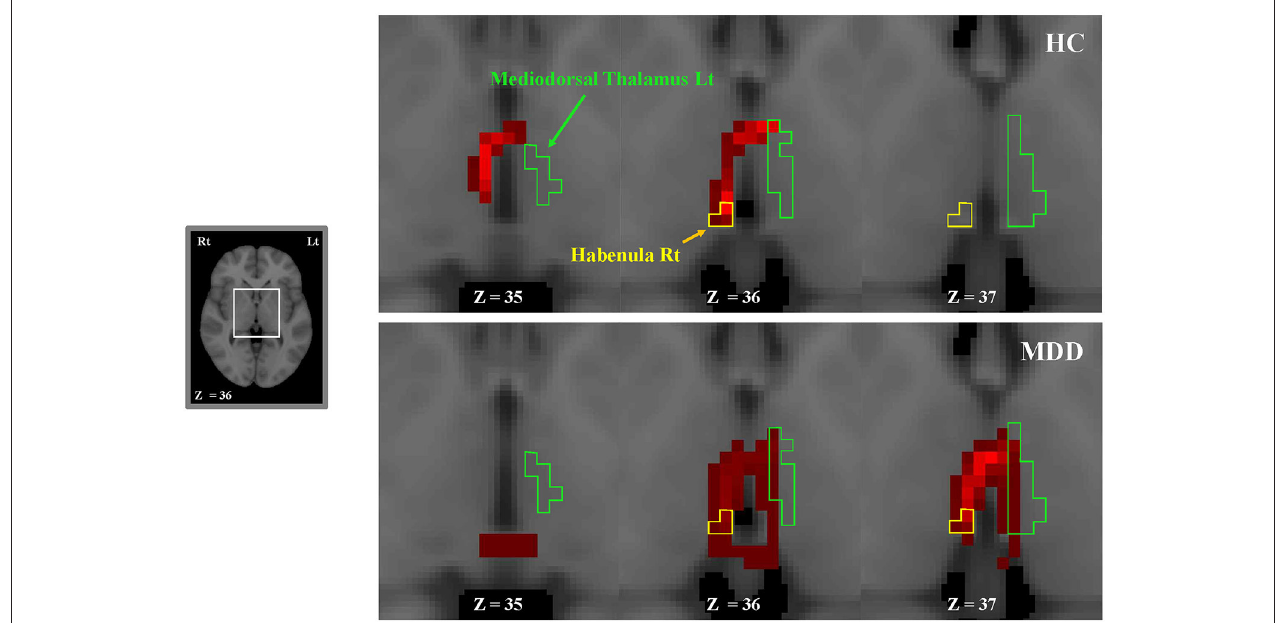
FIGURE 2 | Consecutive tractography images in a representative MDD (bottom) and NC (top) participant. The tracts extend from the left or right habenula to the left or right thalamus (ipsilaterally or contralaterally). More fiber connections between the right habenula and the left mediodorsal thalamus are shown in the MDD group than in NCs. We visualized fiber connections between the right habenula and the left mediodorsal thalamus in red. The green and yellow boundaries represent regions of the left thalamus and the right habenula, respectively. Lt, left; MDD, major depressive disorder; NC, normal control; Rt, right.